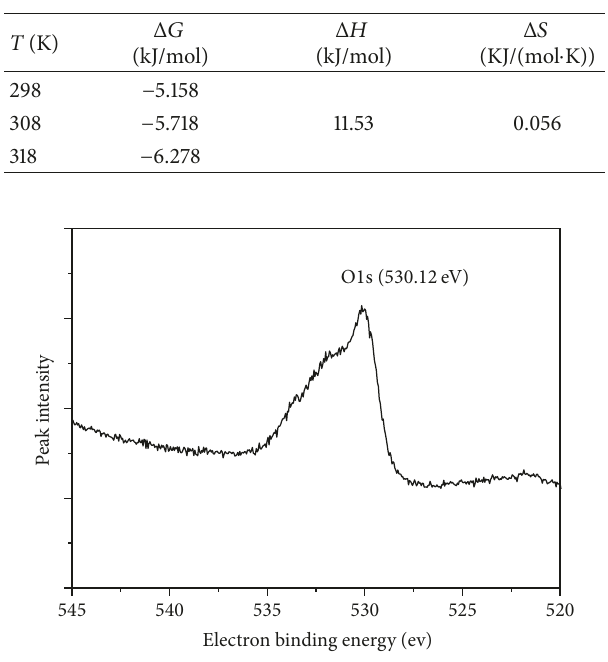
Figure 13: The spectrum of O1s before adsorption.